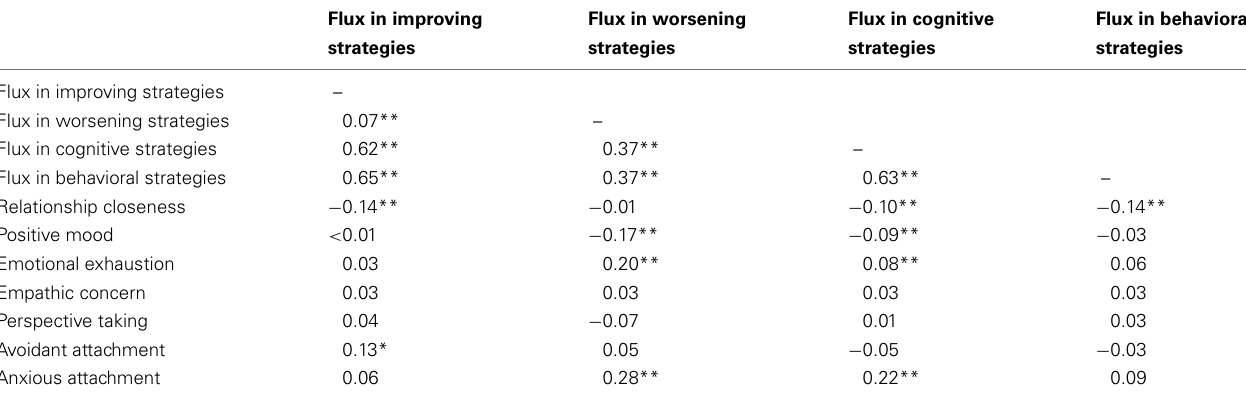
Table 6 | Correlations between variability in the use of different types of strategies and main study